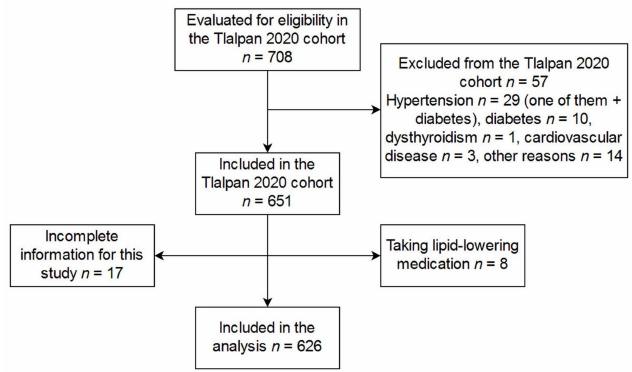
Figure 1. Flow diagram of participants. This study included volunteers from the Tlalpan 2020 cohort. In addition to the criteria of the cohort, those participants taking lipid-lowering medication were excluded from this